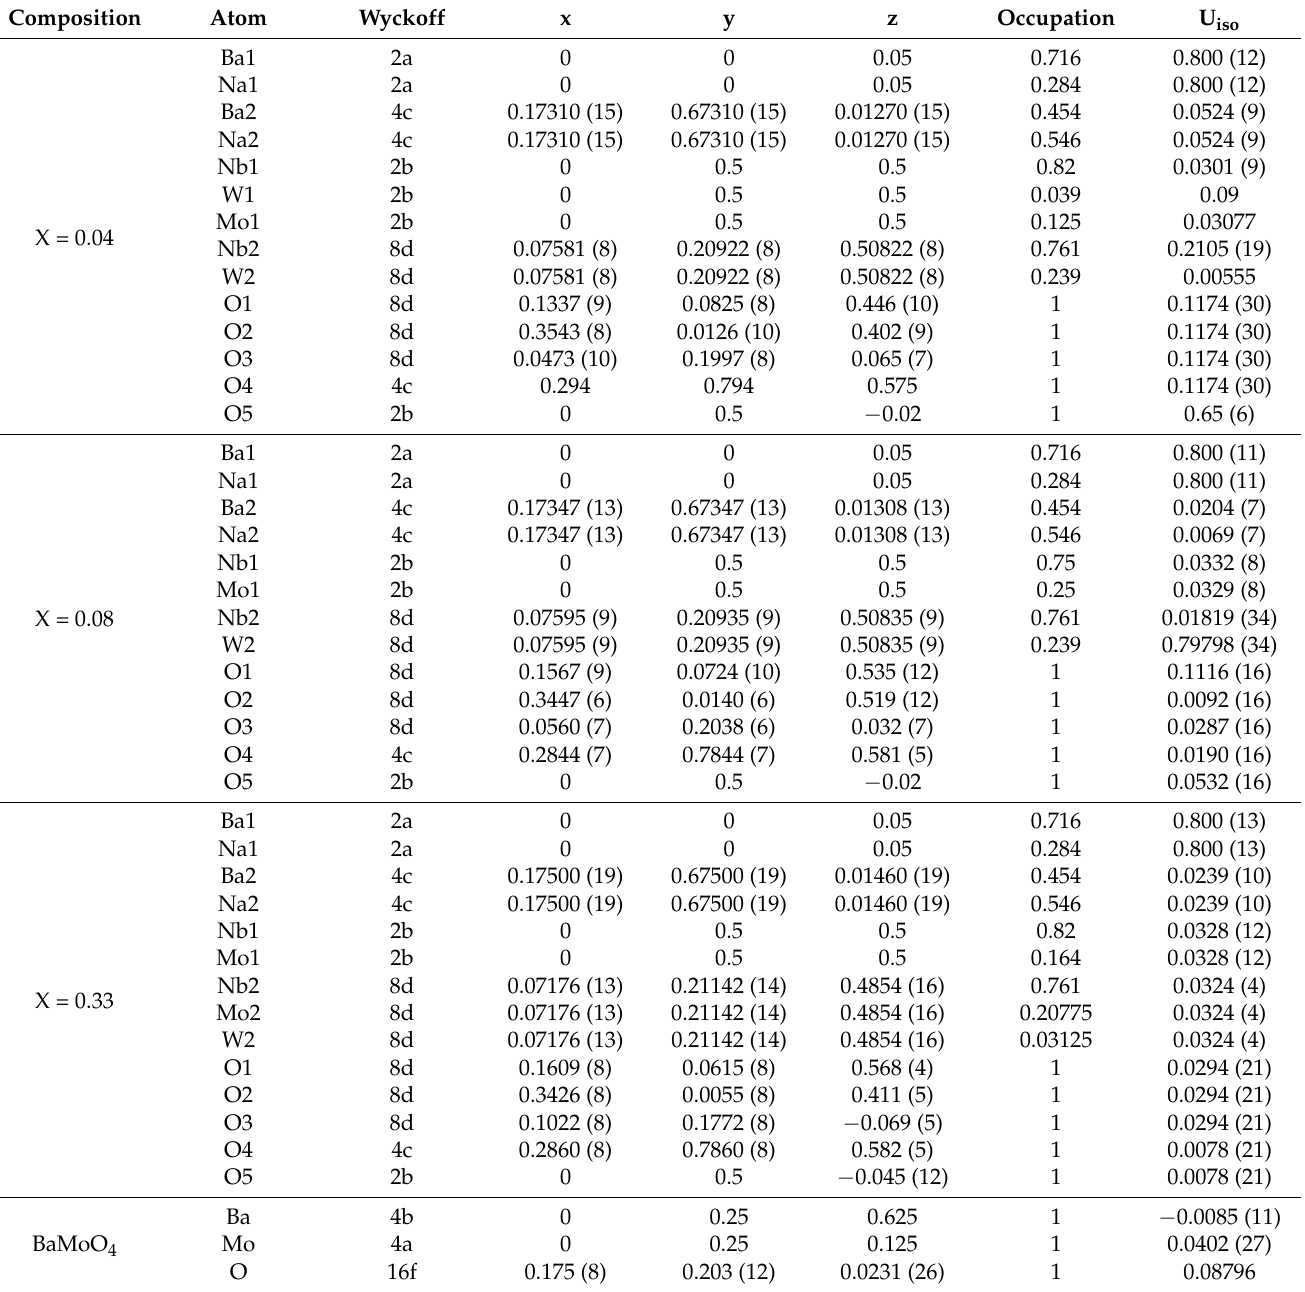
Table 2. Atomic positions of the Ba 0.54 Na 0.46 Nb 1.29 W (0.37 − x) Mo x O 5 system (x = 0.04, 0.08, and